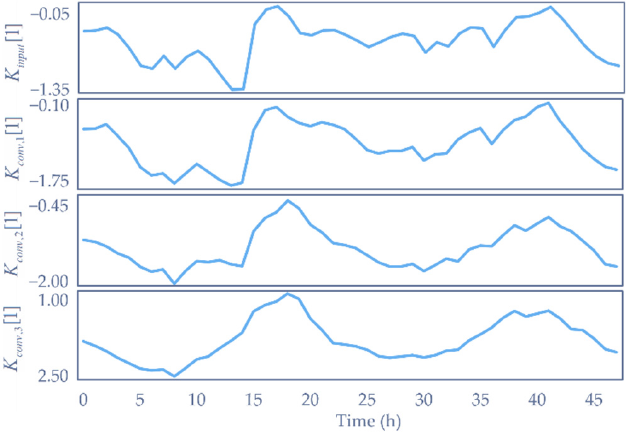
Figure 5. Modals of key decomposed by convolution.